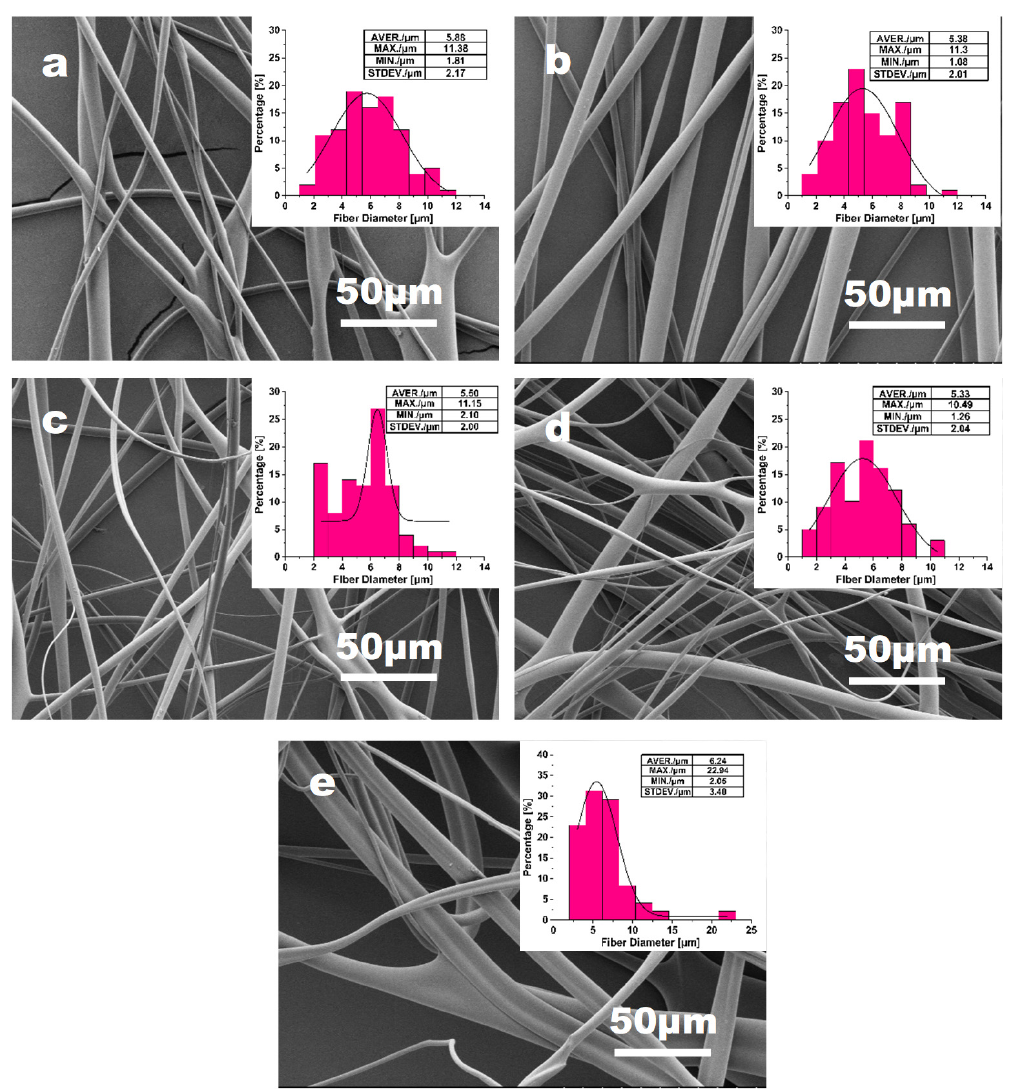
Figure 7. The effect of feeding rate: ( a ) 2900 mL h − 1 ; ( b ) 3000 mL h − 1 ; ( c ) 3100 mL h − 1 ; ( d ) 3200 mL h − 1 ; ( e ) 3300 mL h − 1 on the PVA fiber morphology and fiber diameter distribution, with fixed parameters of rotation speed = 5500 rpm and needle 22# (0.51 mm diameter).